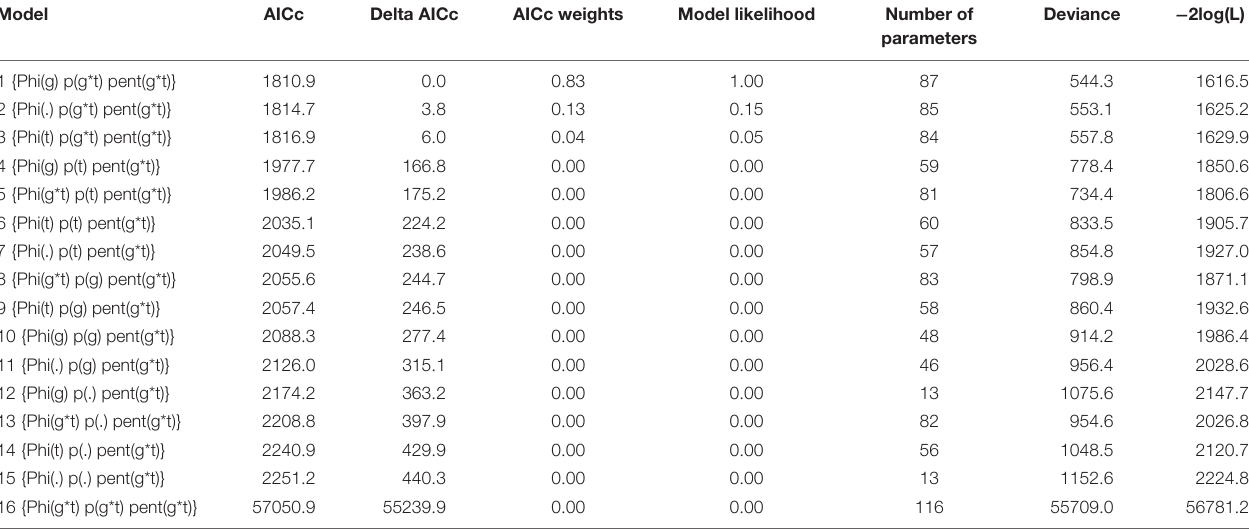
TABLE 2 | Set of candidate models arranged in ascending order by AICc for population analysis of the bottlenose dolphin off Alvarado Veracruz System, southwestern Gulf of Mexico, between 2006 and 2010. Model